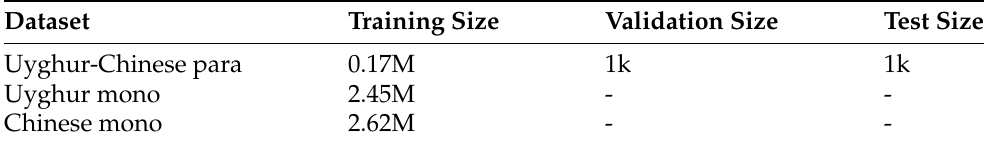
Table 1. Preprocessed parallel and monolingual